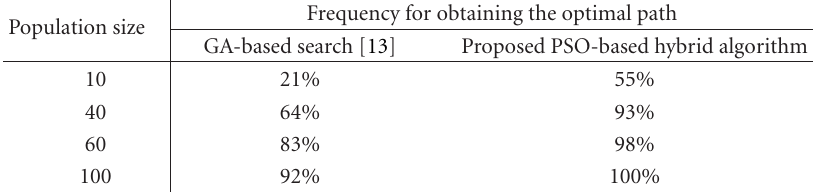
Table 4 . 5 . Comparison of statistical results between GA-based search [13] and proposed algorithm for test number 2. Population size